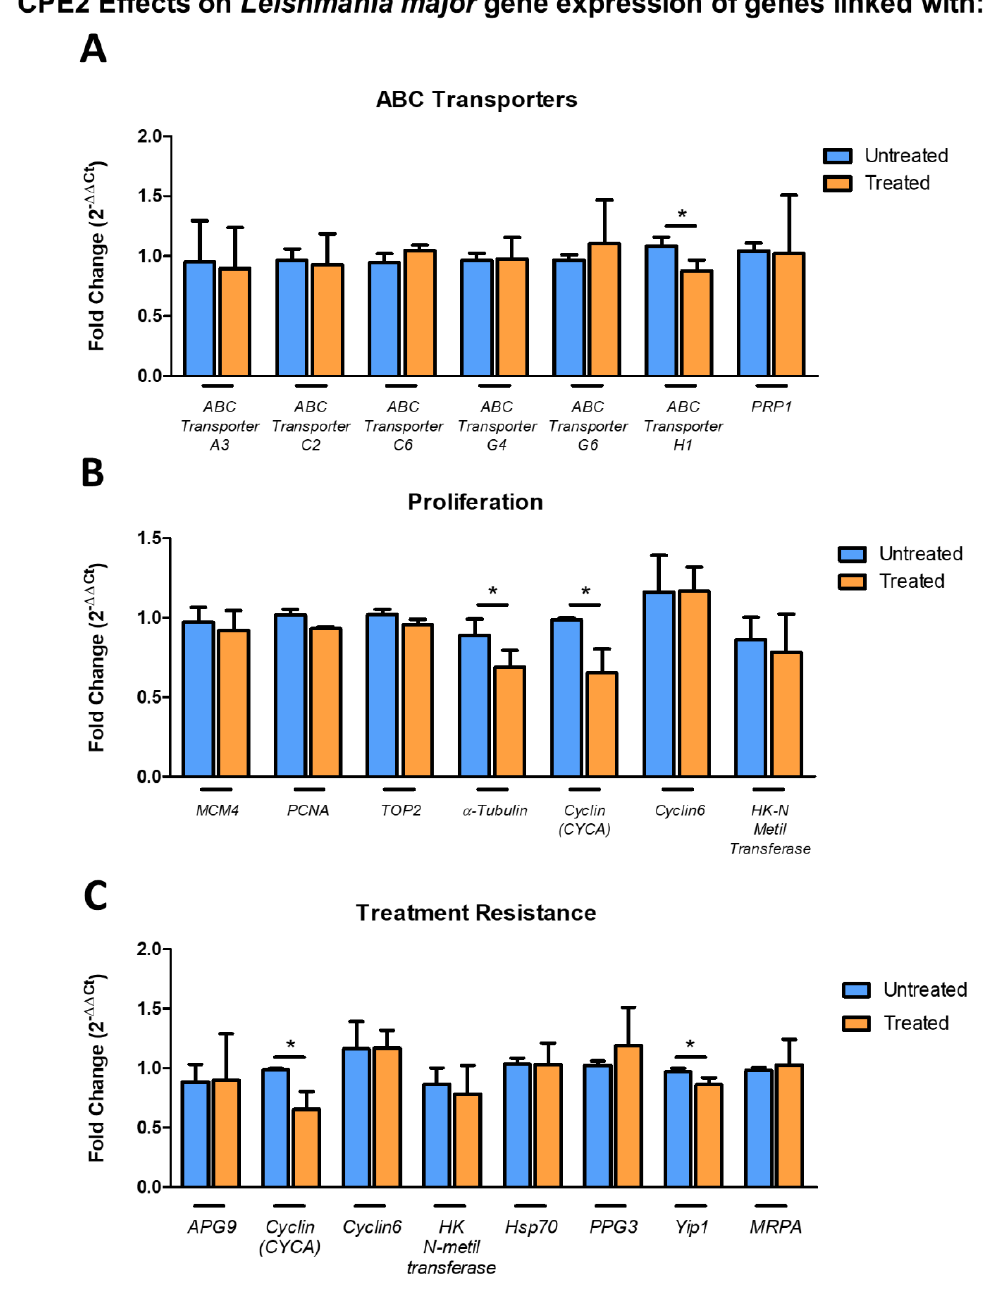
Figure 12. Effect of CPE2 on L. major promastigotes gene expression. mRNA levels of ( A ) selected ABC transporter genes, ( B ) genes related to proliferation, ( C ) genes associated with treatment resistance after 48 h of treatment with compound CPE2 (50 µM). The bars represent the means ± the SD from three independent experiments. (*, p < 0.05).